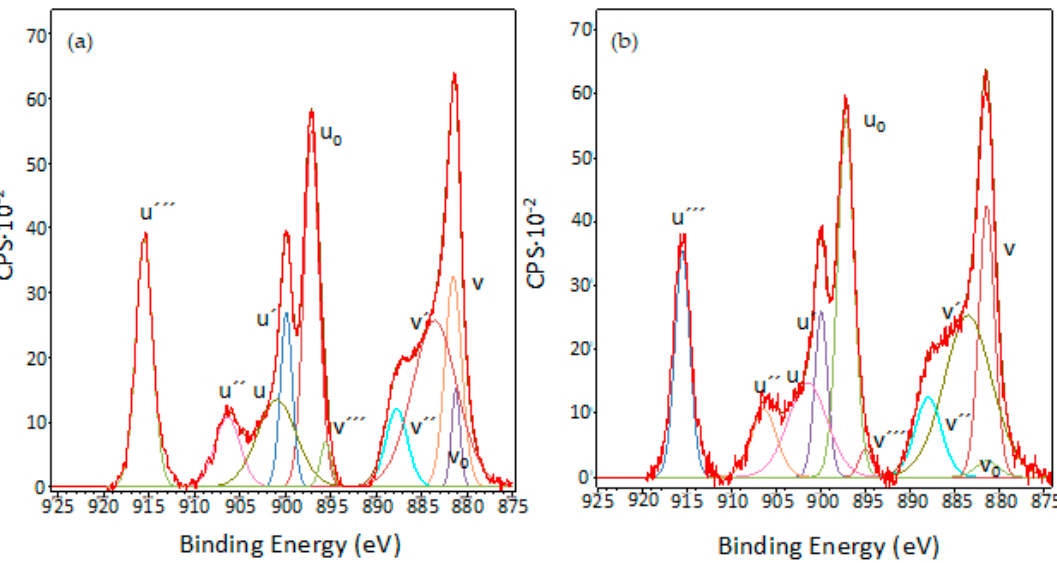
Figure 12. Survey X-ray photoelectron spectroscopy (XPS) spectra of ( a ) CeCC-1 and ( b ) CeCC-2. Table 4. Surface composition of samples CeCC-1 and CeCC-2 (at. %).